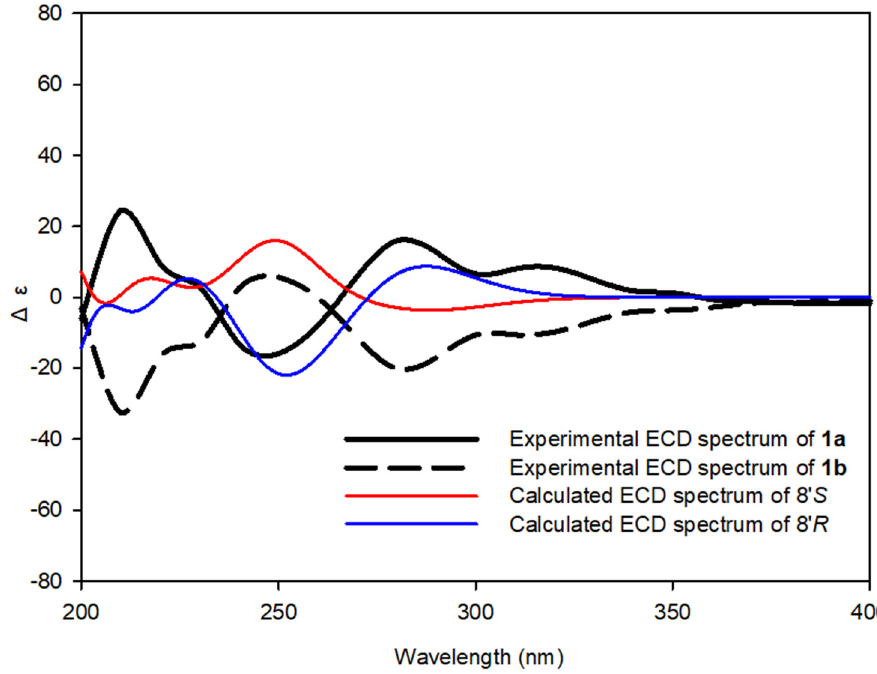
Figure 4. Calculated and experimental electronic circular dichroism (ECD) spectra of 1a and 1b .